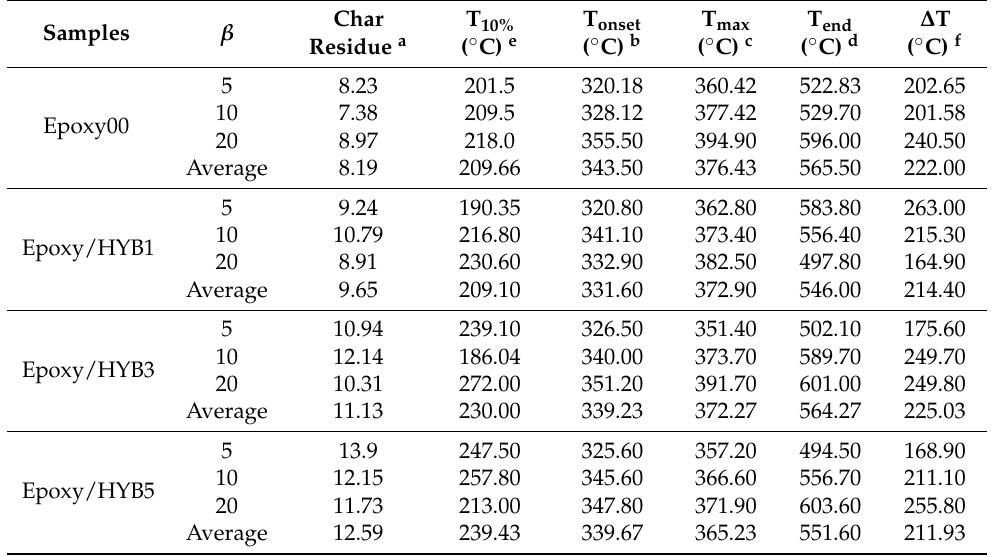
Table 2. Result of TG/DTG traces of some epoxy nanocomposites in a nitrogen atmosphere.